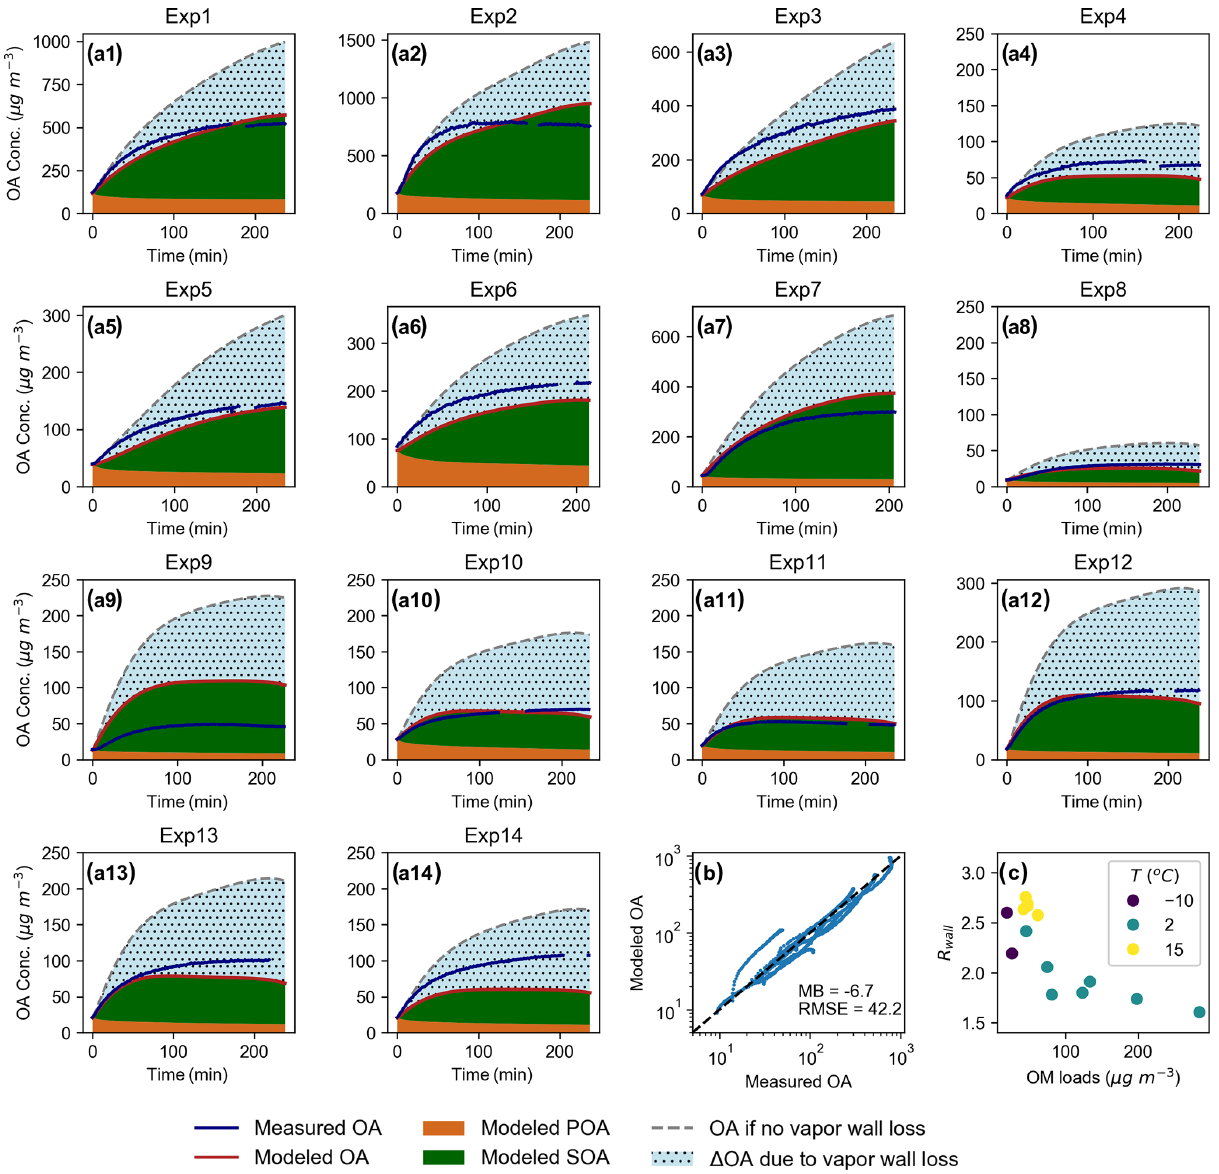
Figure 1. Comparison between measured and modeled OA with an optimized parameterization under k w = 0 . 0033s − 1 and C wall = 5mgm − 3 (a, b) . Relation between the end-point wall loss factor R wall of each experiment and initial OM loads under different temper- ature (c) . The gray dashed lines in (a) represent modeled OA with the same parameterization but k w =